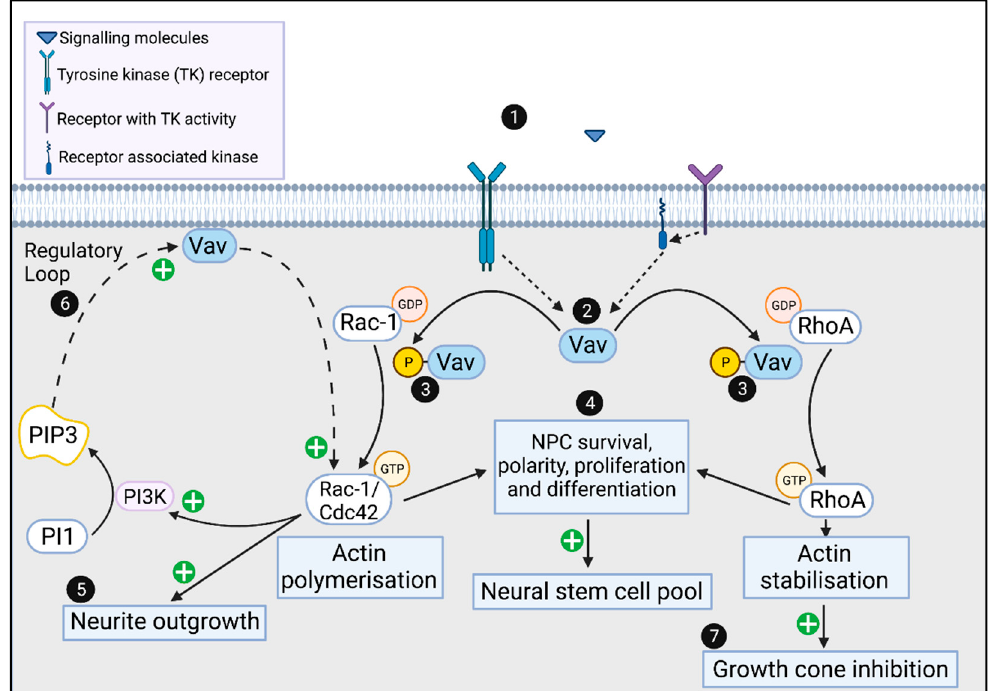
Figure 2. Vav and Rho family GTPase signaling in NPC and neurons. (1) signaling molecules such as NGF, BDNF and Ephrins bind to tyrosine kinase receptors or receptors with associated tyrosine kinases, such as Src/Syk, which can (2) stimulate phosphorylation of Vav. Phosphorylated Vav acts as a guanosine exchange factor to (3) activate Rho family GTPases (Rac1, Cdc42 and RhoA). In neurons, Rac1, Cdc42 and RhoA are involved in maintaining NPC polarity, regulating survival, proliferation and differentiation, which is important for (4) maintenance of the neural stem cell pool. GTP- Rac1/Cdc42 can mediate neurite outgrowth via actin polymerization within the growth cone (5) and activate PI3K, which generates PIP3 that in a regulatory loop, activates Vav to further activate Cdc42/Rac1 (6). GTP-RhoA inhibits the growth cone/neurite outgrowth through actin stabilization (7). Created with BioRender.com (https://biorender.com (accessed 7 January 2022).